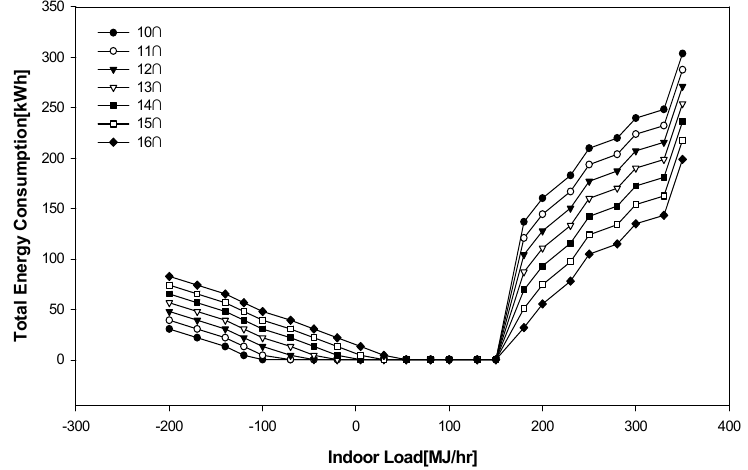
Figure 8. Indoor Load and Prediction Load trend over time.